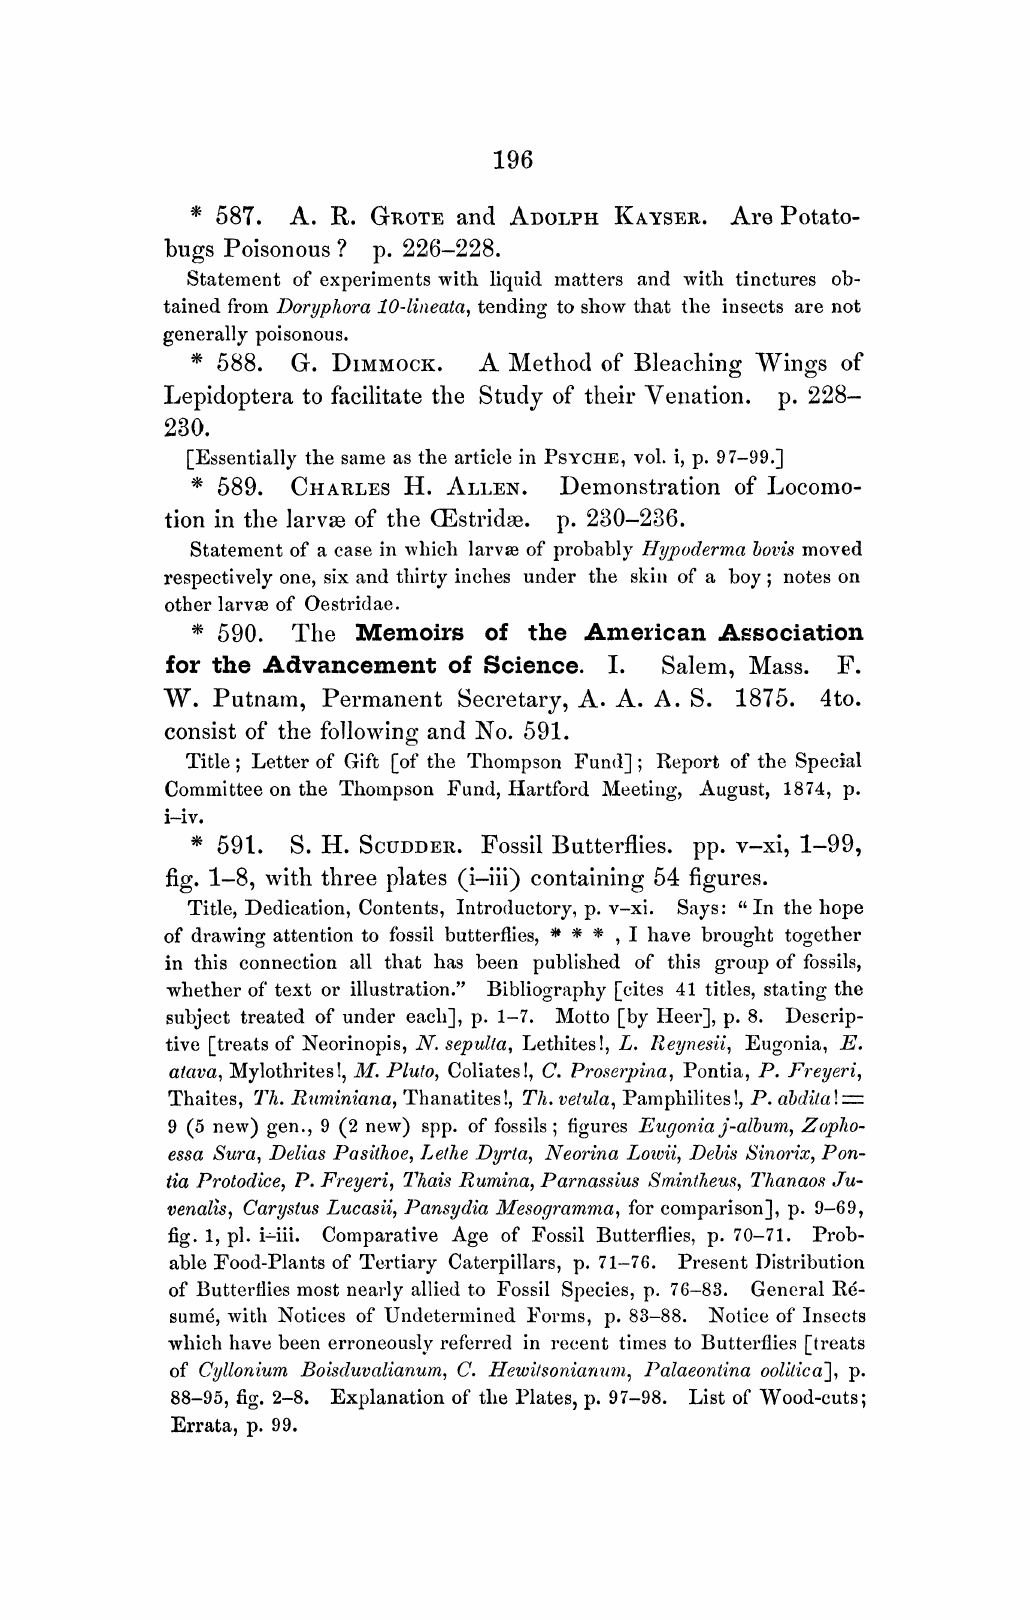
fig. 1, pl. i:-iii. Comparative Age of Fossil Butterflies, p. 70-71. Prob- able :Food-Plants of Tertiary Caterpillars p. 71-76. Present